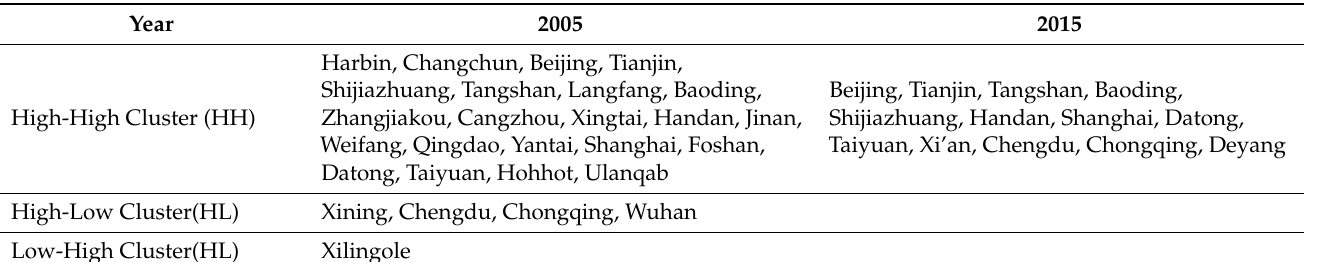
Table 2. Classification of high-low carbon emission concentrations of urban households.